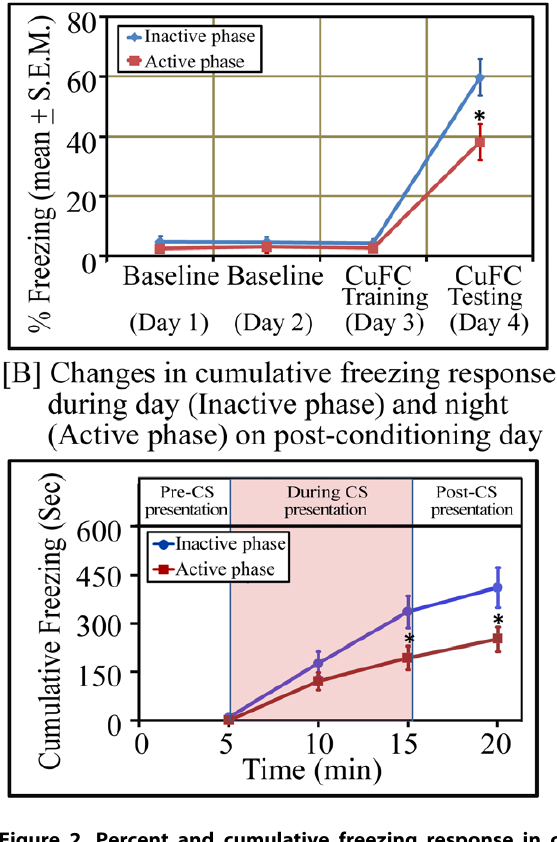
Figure 2. Percent and cumulative freezing response in cued fear-conditioned animals during lights-on and lights-off phas- es. Rats trained for CuFC exhibited significant increase in [A] percent freezing (p , 0.05; F (1,17) =6.26) and [B] cumulative freezing